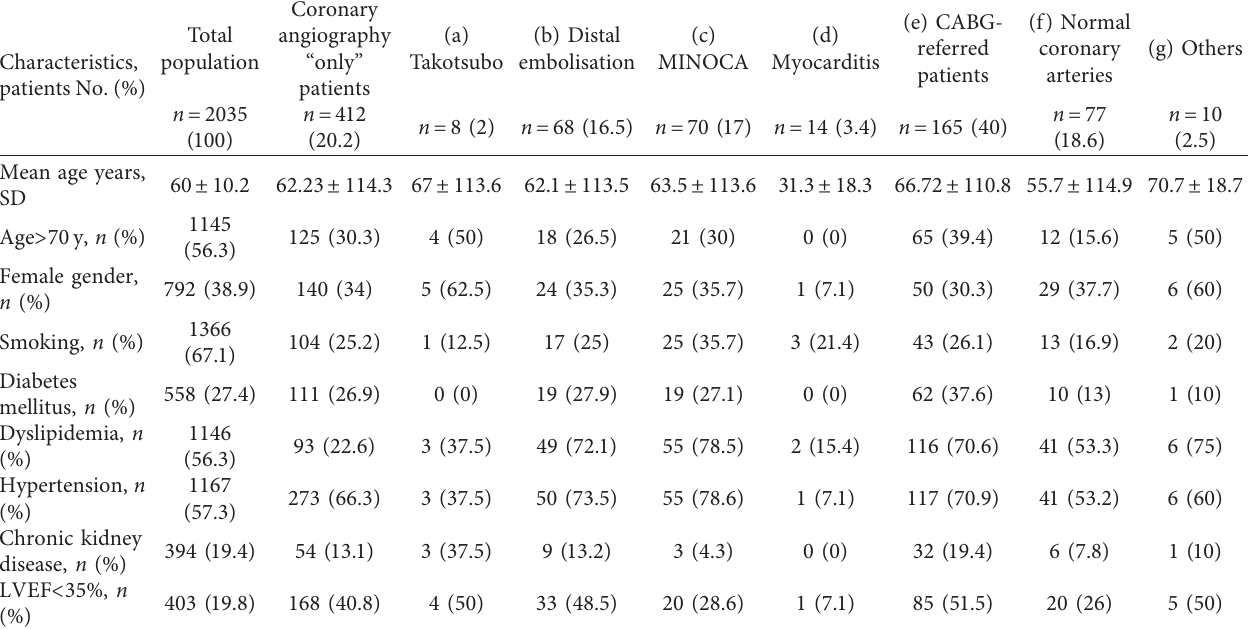
Table 1: Main characteristics of the entire study population and coronary angiography “only” categories.